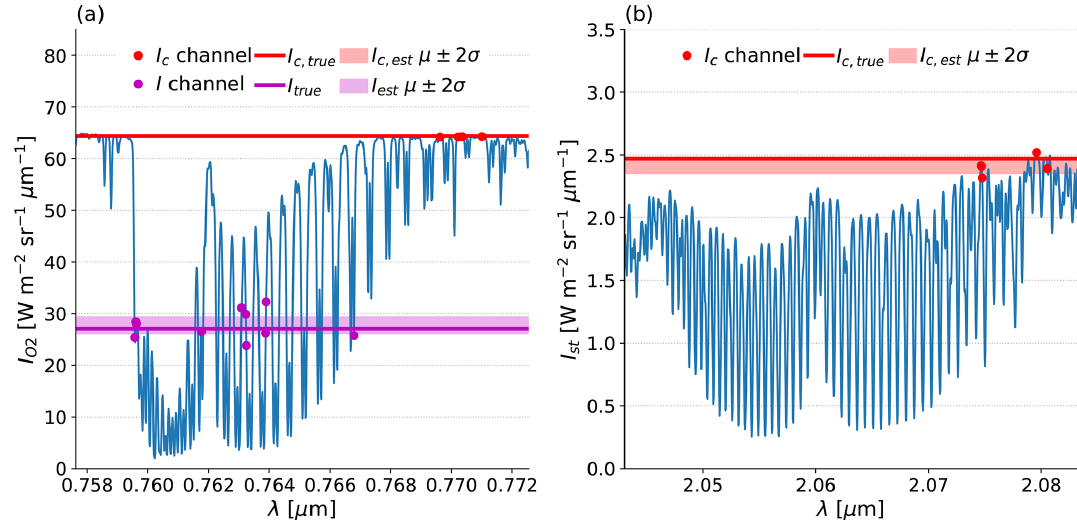
Figure 2. Mean cloudy-scene spectra in (a) the O 2 A-band and (b) the strong CO 2 band. The channels used in the lookup tables are shown as points, with red for the continuum radiance I c and magenta for the O 2 absorption band radiance I . Thick horizontal lines represent the truth, either the L1bSc file’s continuum radiance for I c or the mean of the 600–609th brightest undamaged channels (i.e. the 60th super channel) for I . The shaded bands of the same colour are the mean ± 2 standard errors based on the selected channel sample sizes (5 for I c and 10 for I)